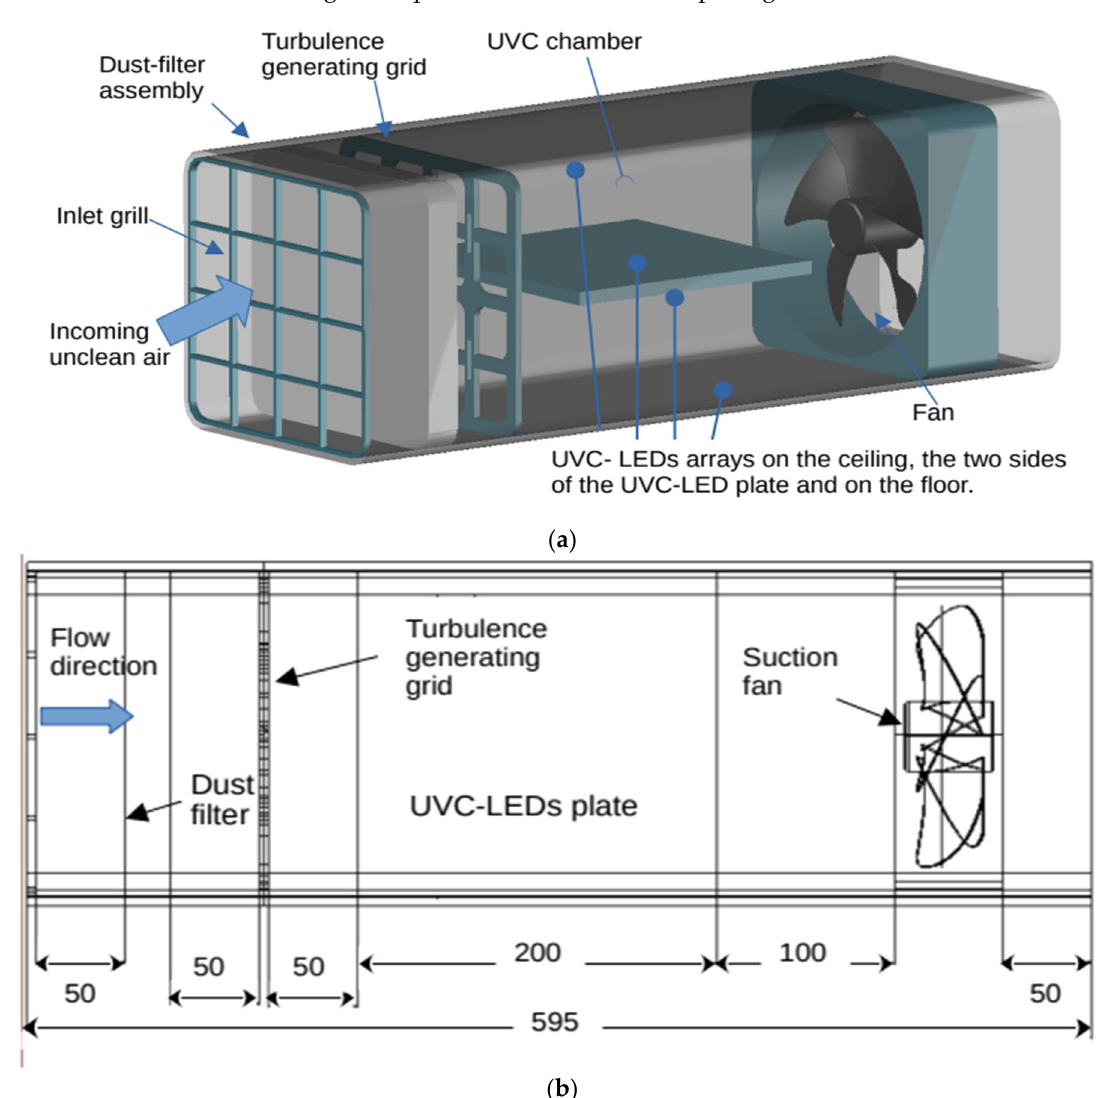
Figure 1. Conceptual design of the UVC ‐ LED air purifier in ( a ) isometric view and ( b ) longitudinal cross ‐ section, where all units are in mm.